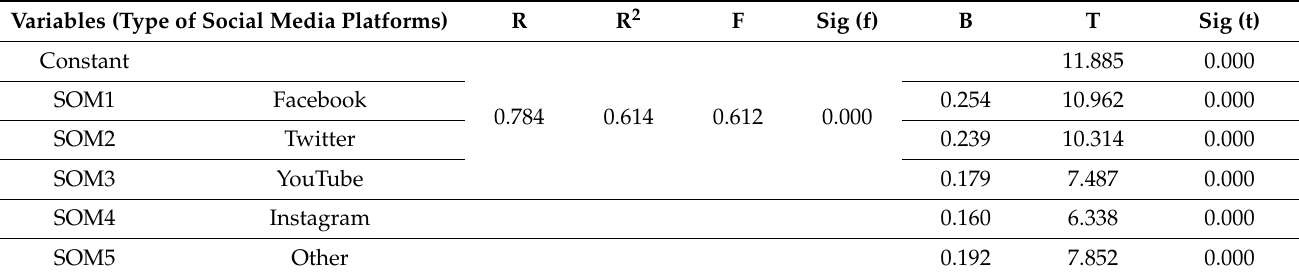
Table 5. Result for hypothesis